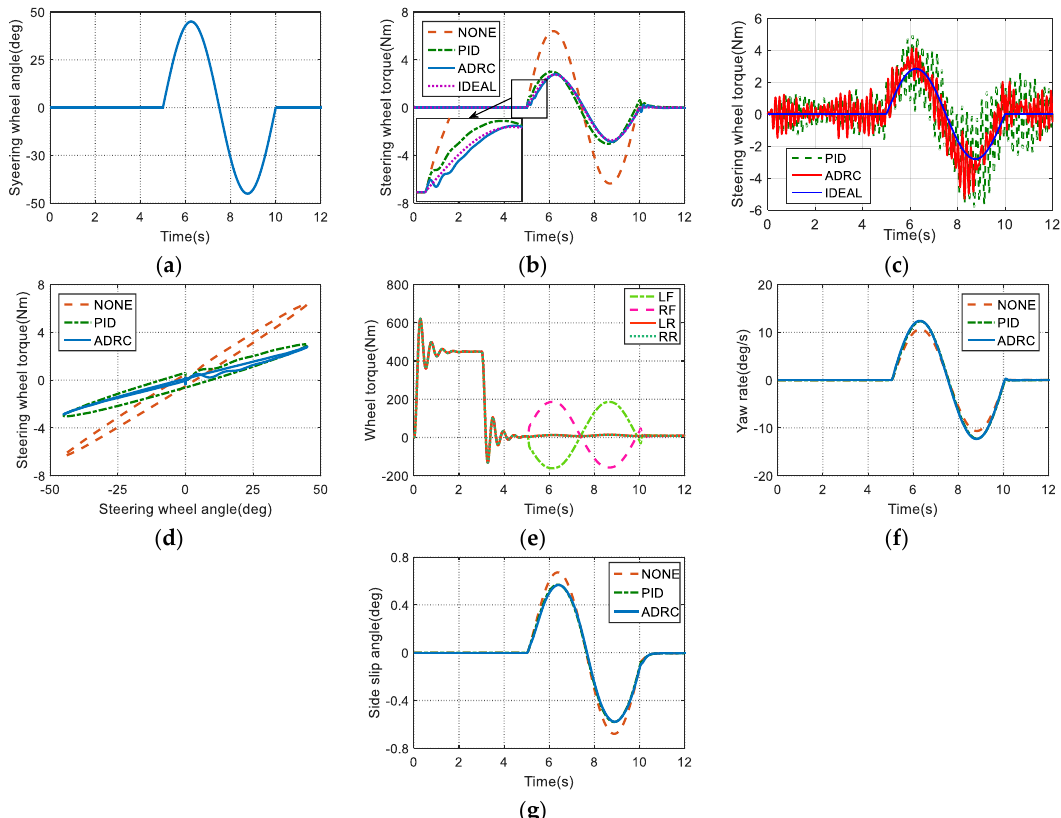
Figure 11. Sinusoidal input simulation: ( a ) Steering wheel angle; ( b ) Steering wheel torque; ( c ) Steering wheel torque with white noise; ( d ) Cross-plot of steering wheel angle and torque; ( e ) Wheel torque of ADRC controller; ( f ) Yaw rate; ( g ) Side slip angle.